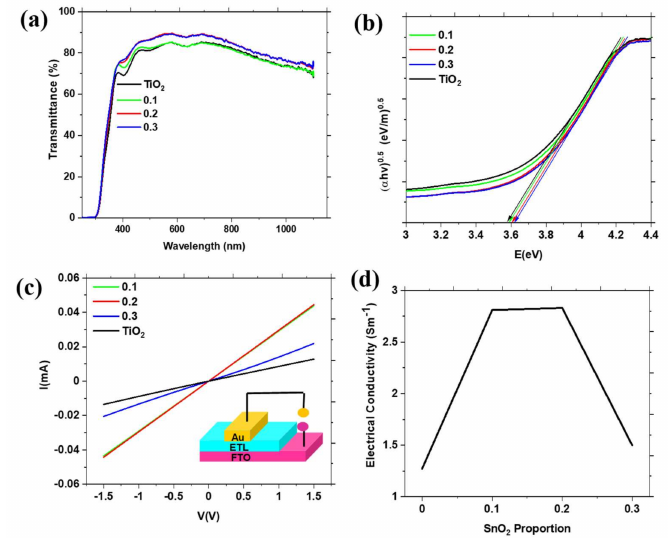
Figure 5. Optoelectronic Behavior of ETLs films: ( a ) Transmittance, ( b ) Tauc plot from absorbance ( c ) Dark I-V curves of the films and ( d ) Electrical